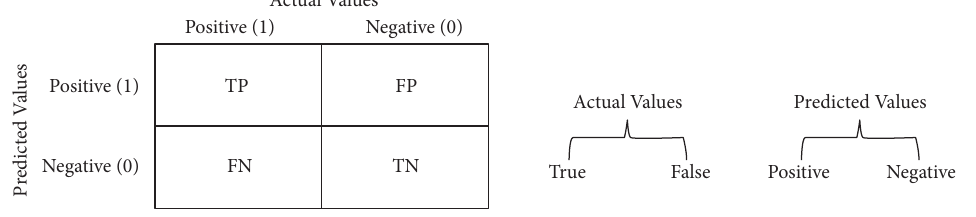
Figure 2: Confusion matrix.